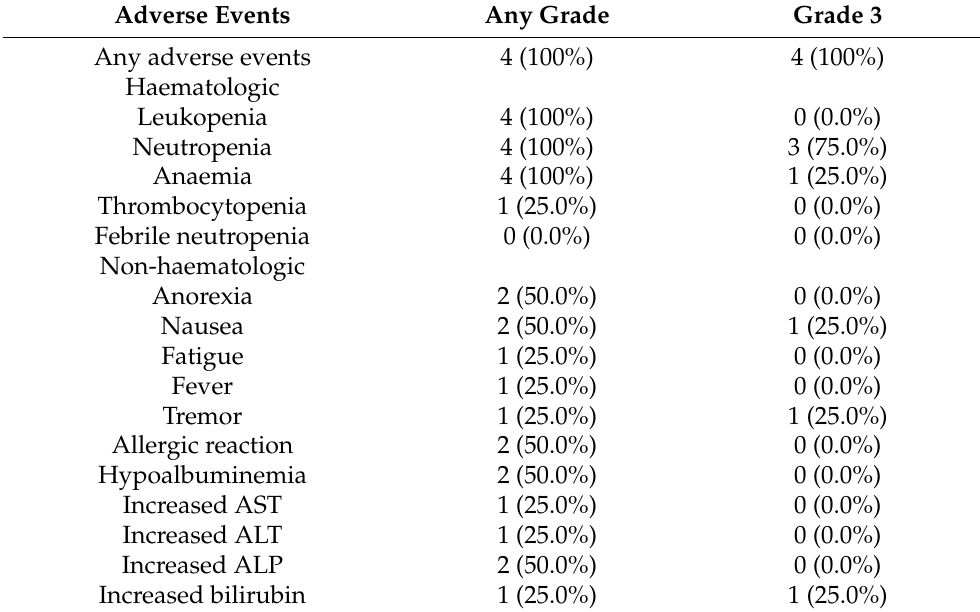
Table 4. Adverse events of trastuzumab-pkrb +